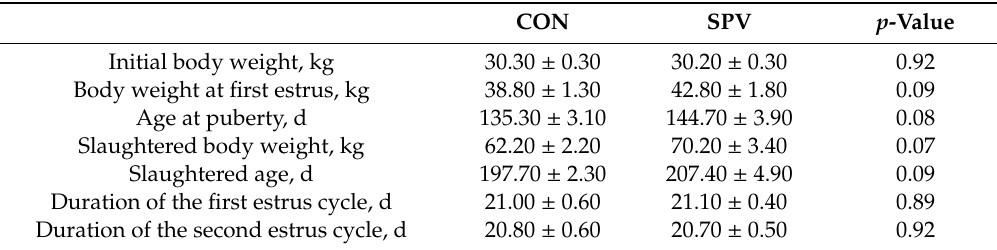
Table 4. E ff ect of sweet potato vine supplementation on estrus in Meishan gilts. CON SPV p -Value Initial body weight, kg